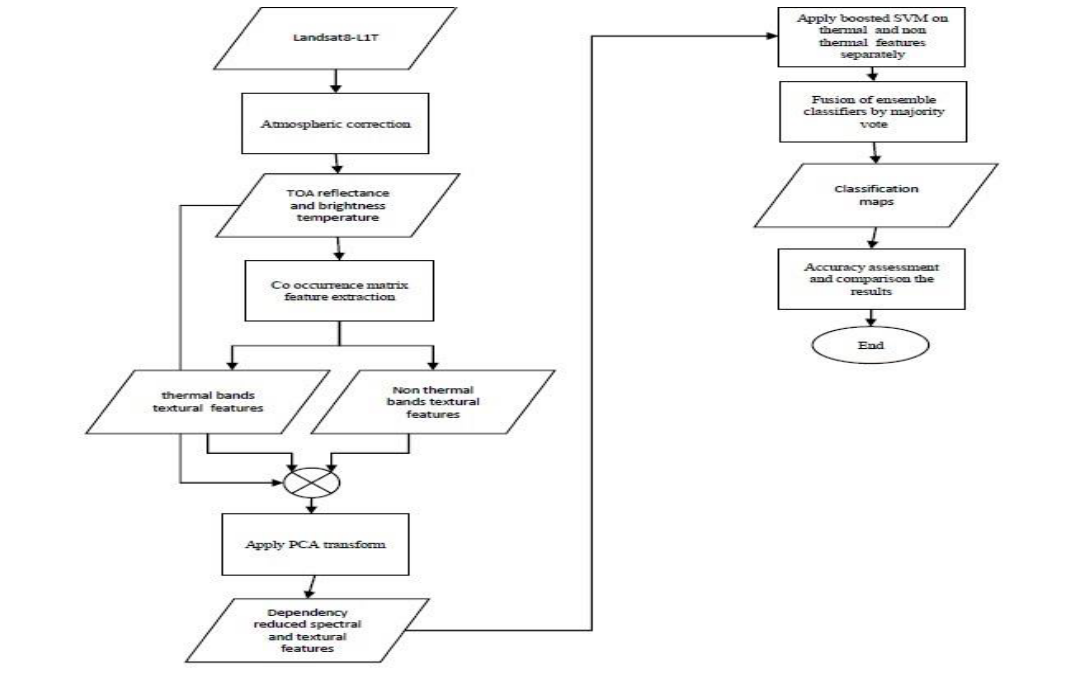
Fig. 4: work flow of